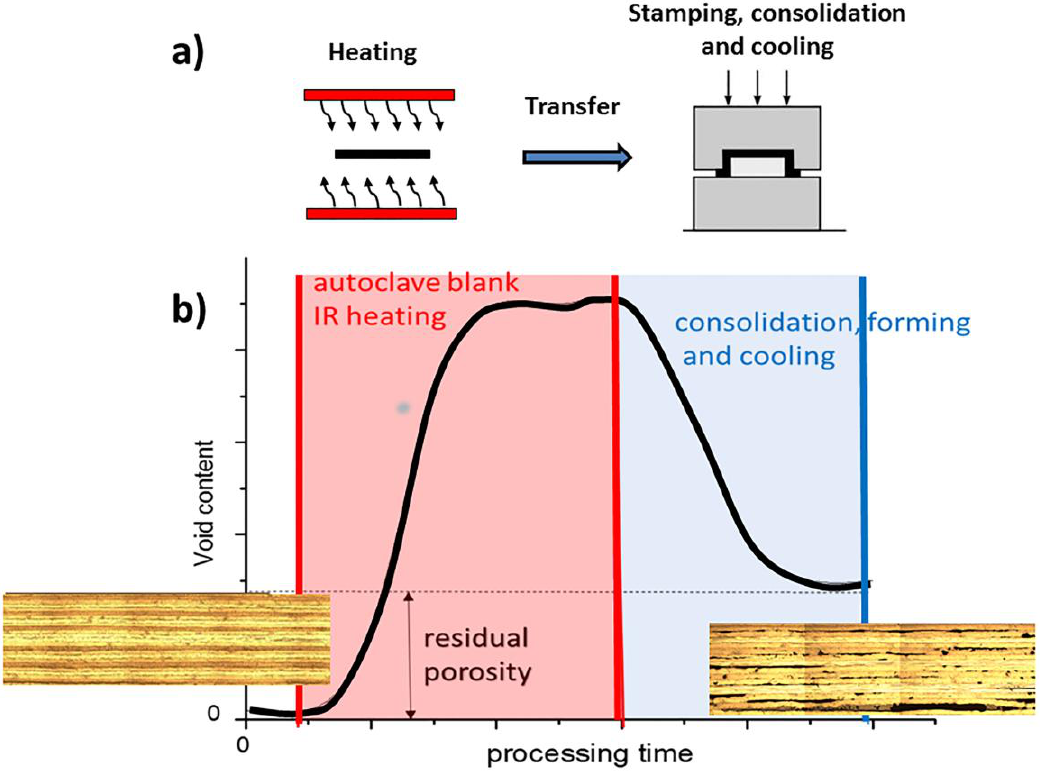
Figure 1. Schematic representation of the press forming process and the qualitative evolution of porosities during press forming.